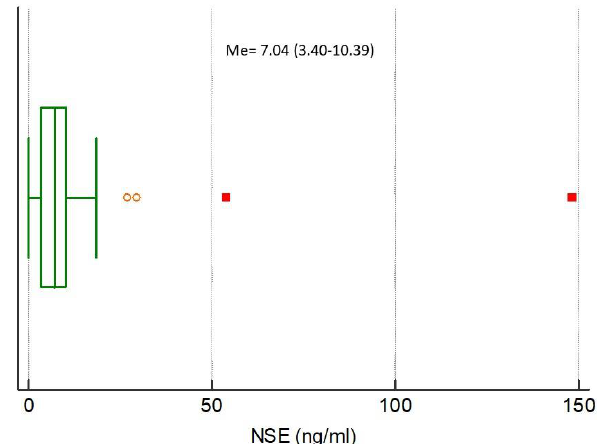
Figure 3. Distribution of the neuron-specific enolase (NSE) concentrations in the study population. Circles and squares indicate outliers and far out values illustrated as single data points.